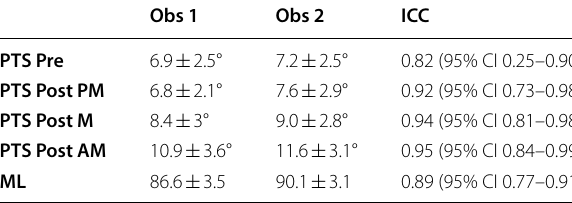
PTS, posterior tibial slope; Pre, preoperative; Post, postoperative; PM, posteromedial; M, medial, AM, anteromedial; ML, mediolateral; Obs,